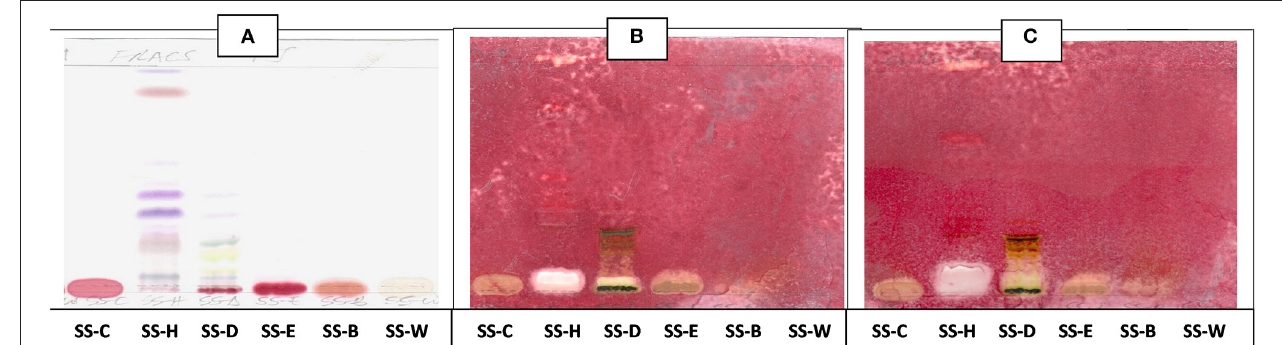
FIGURE 2 | (A) Chromatogram developed in BEA [benzene: ethanol: ammonium hydroxide (90:10:1)] of S. singueana fractions sprayed with vanillin. (B) Bioautography of S. aureus –TLC plate developed with BEA (90:10:1). (C) Bioautography of S. Enteritidis –TLC plate developed with BEA (90:10:1). SS-C, S. singueana crude extract; SS-H, hexane fraction; SS-D, dichloromethane fraction; SS-E, ethyl acetate fraction; SS-B, butanol fraction; SS-W, Water fraction. White bands indicate compounds that inhibit